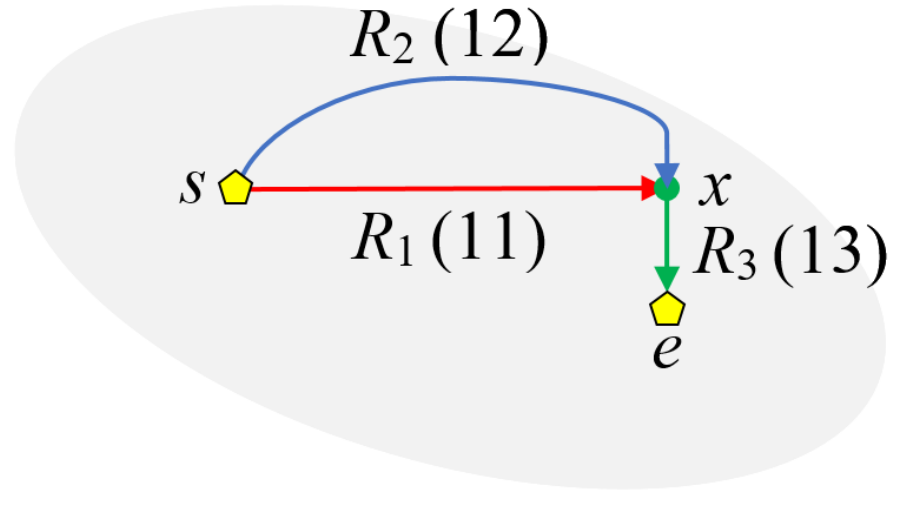
Figure 5. Schematic diagram of a PNA.